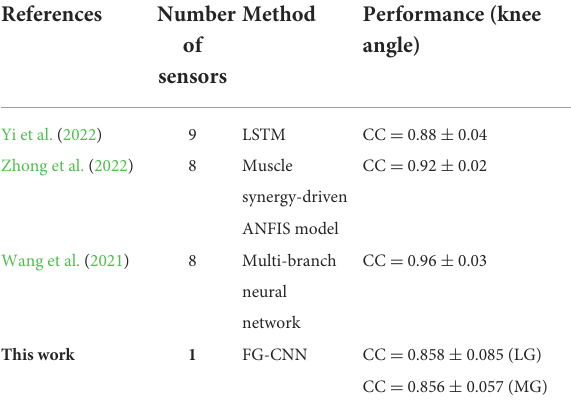
TABLE 1 Statistical analysis results between RF and the other regression models (including LGBM, MLP, SVR, and KNN) on NRMSE and CC.